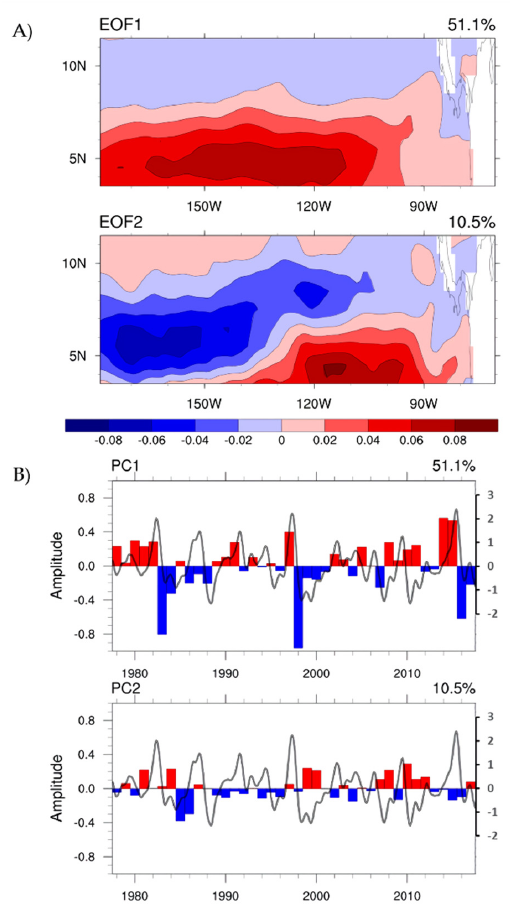
Figure 5. Same as Figure 2, but for spring (MAM): ( A ) spatial pattern and ( B ) time series of the principal component superimposed with 6 months low-pass filtered NIÑO 3.4 index. Red and blue bars represented the NECC’s strengthening and weakening, respectively.